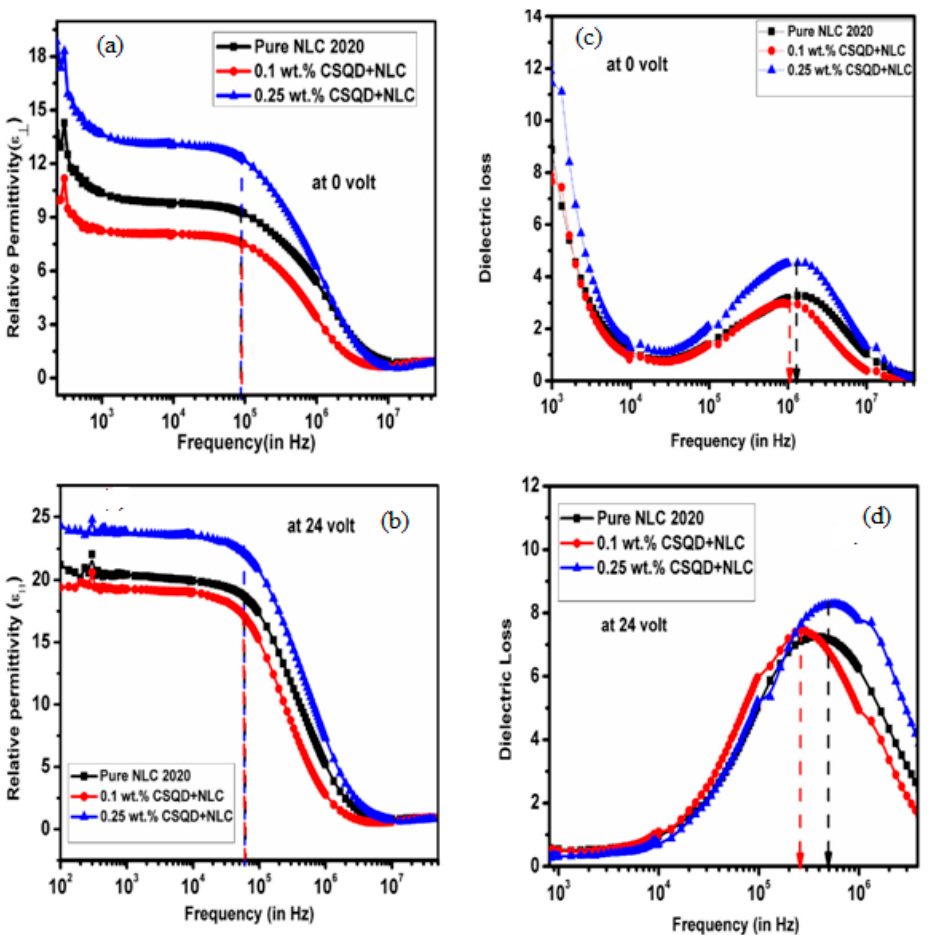
Figure 10. Variationof relative permittivity ( a , b ) and dielectric loss ( c , d ) at fixed temperature without Figure 10 Variationof relative permittivity (( a ), ( b )) and dielectric loss (( c ), ( d )) at fixed temperature bias (0 V) and with bias (24 V) of pristine and Cd 1 − x Zn x S / ZnS QDs dispersed nematic NLC2020 without bias (0 V) and with bias (24 V) of pristine and Cd 1-x Zn x S/ZnS QDs dispersed nematic NLC2020 [14].